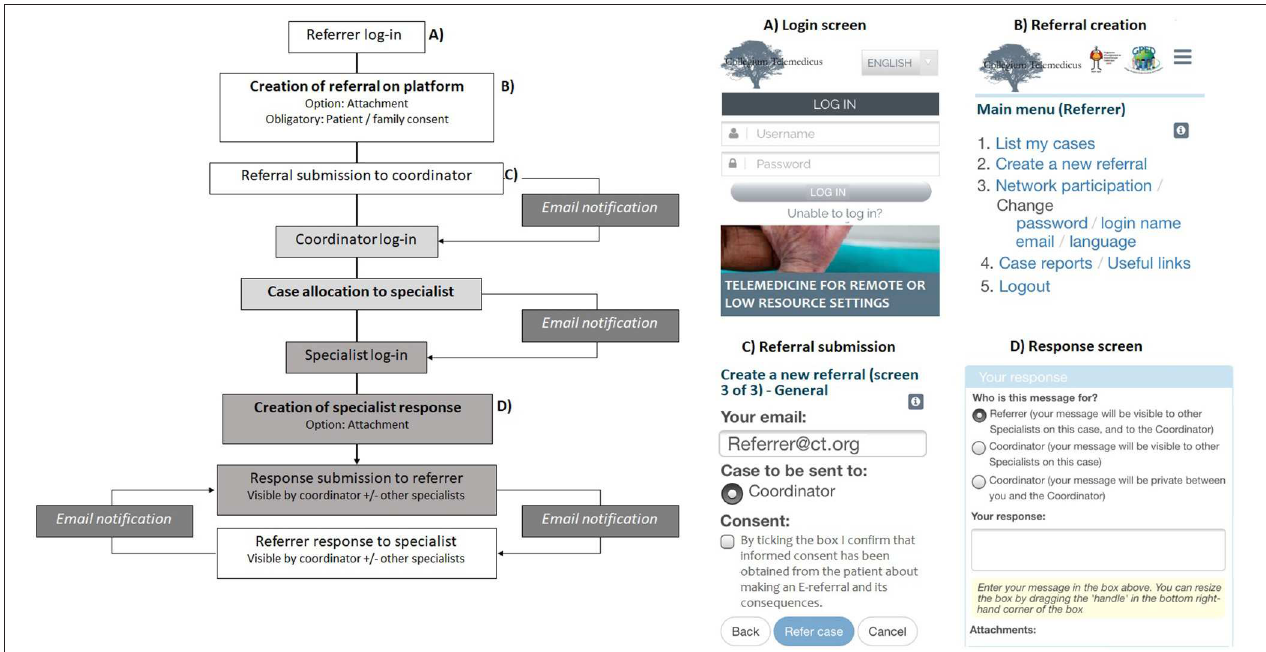
FIGURE 1 | Schematic diagram of store-and-forward teleconsultation process. The referral process from creation of a new referral to specialist response is shown. Screen shots of the platform as viewed by users on a mobile phone are shown in (A–D)